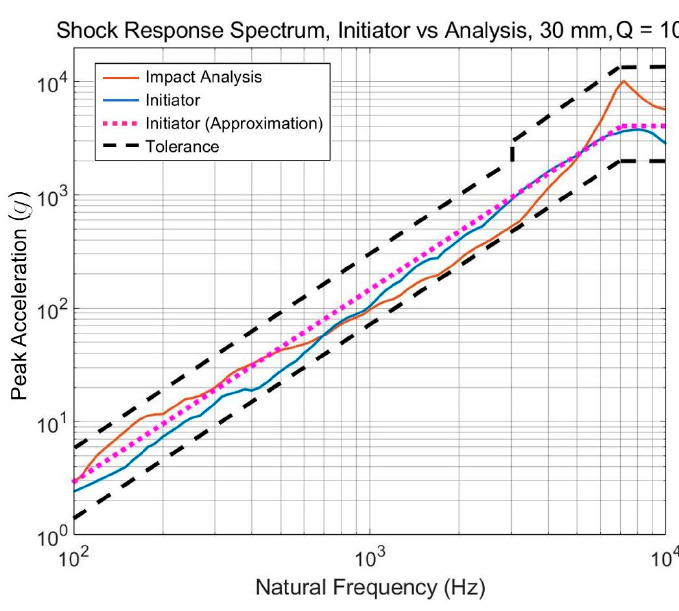
Figure 13. Comparison of SRS between impact analysis and pyrotechnic initiator.